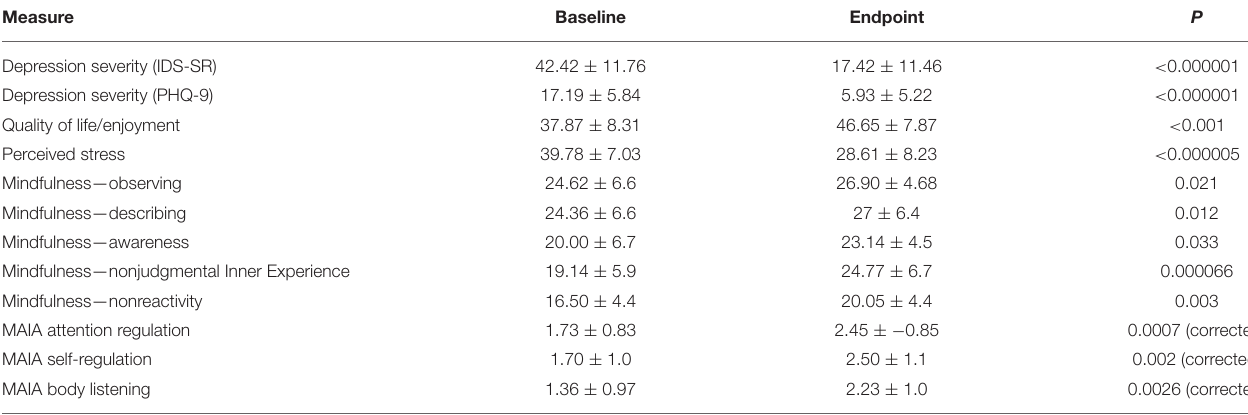
TABLE 2 | Change in clinical measures ( n = 17) a